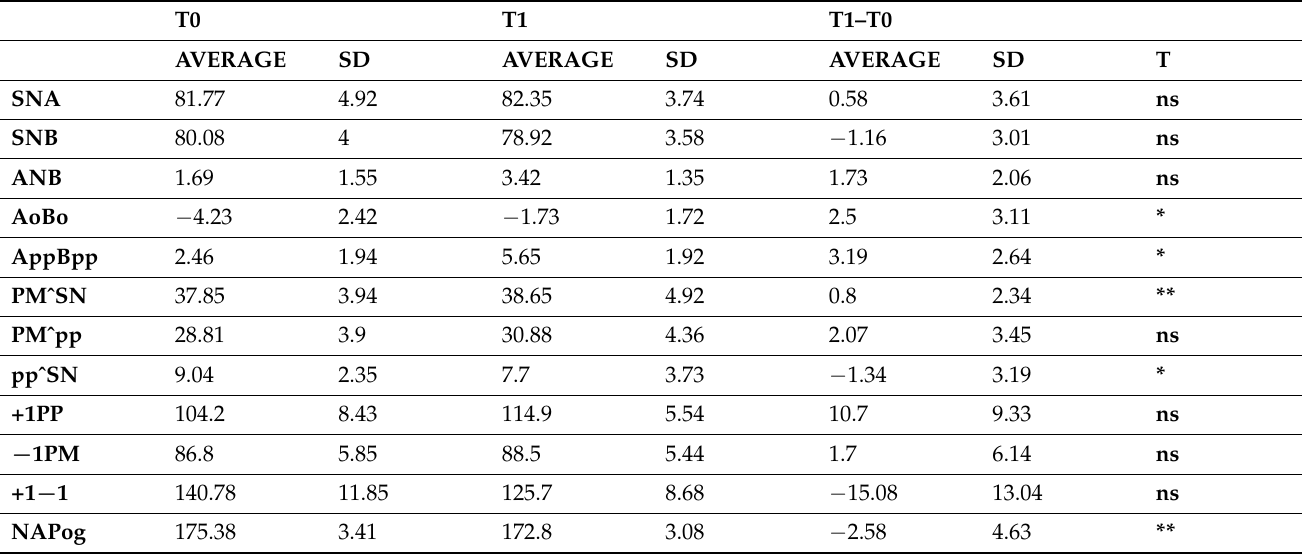
Table 4. Study results for the Delaire + rapid palatal expander